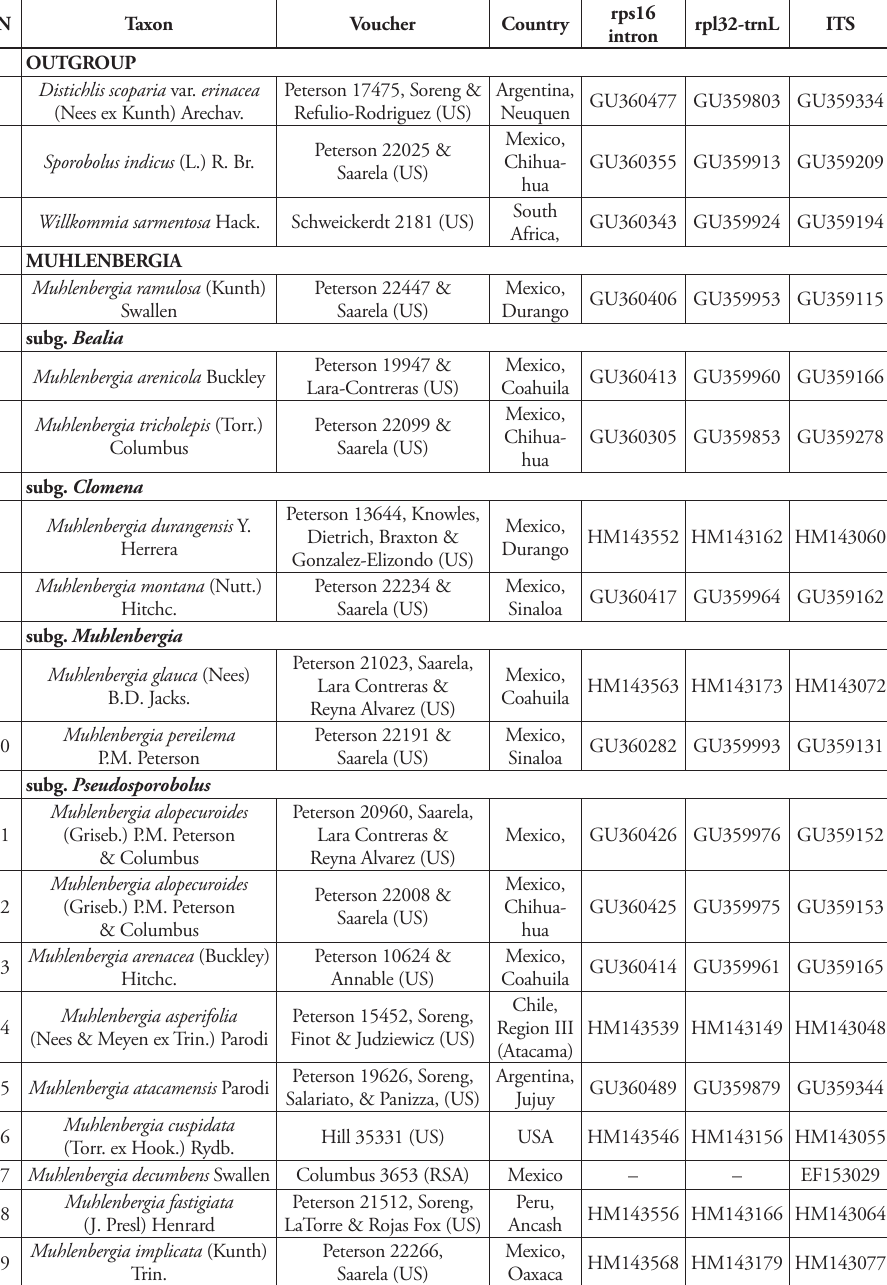
Table 1. Taxon voucher (collector, number and where the specimen is housed), country of origin and GenBank accession for DNA sequences of rps16 intron, rpl32-trnL and ITS regions ( bold indicates new accession); a dash (–) indicates missing